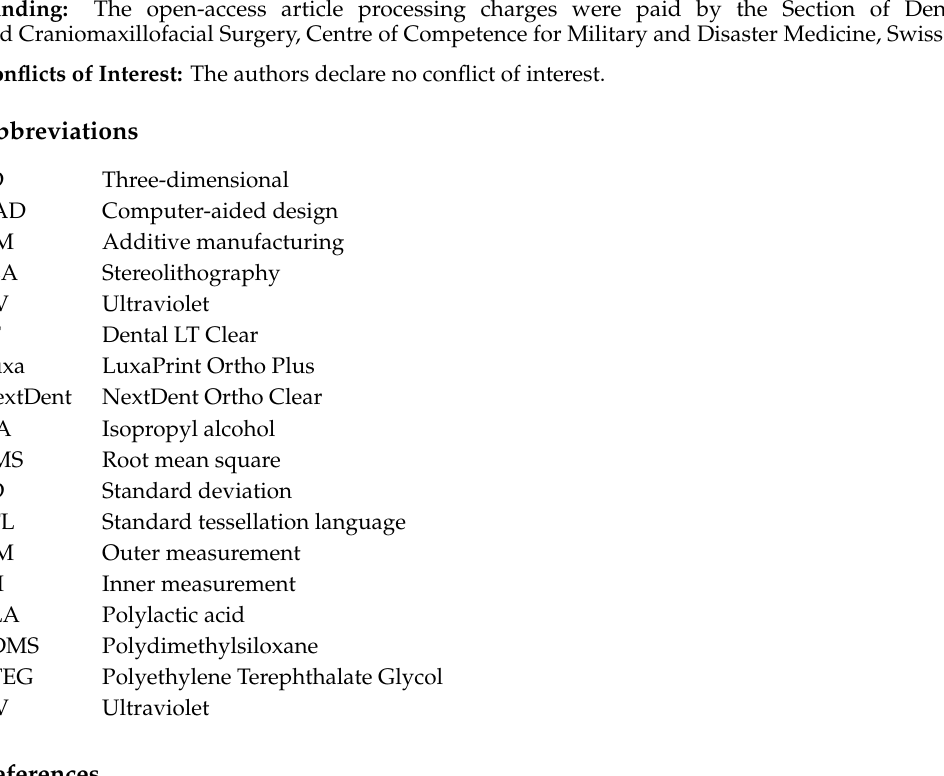
Table S1: Pre- and post-sterilization percentage change in dimensions of test